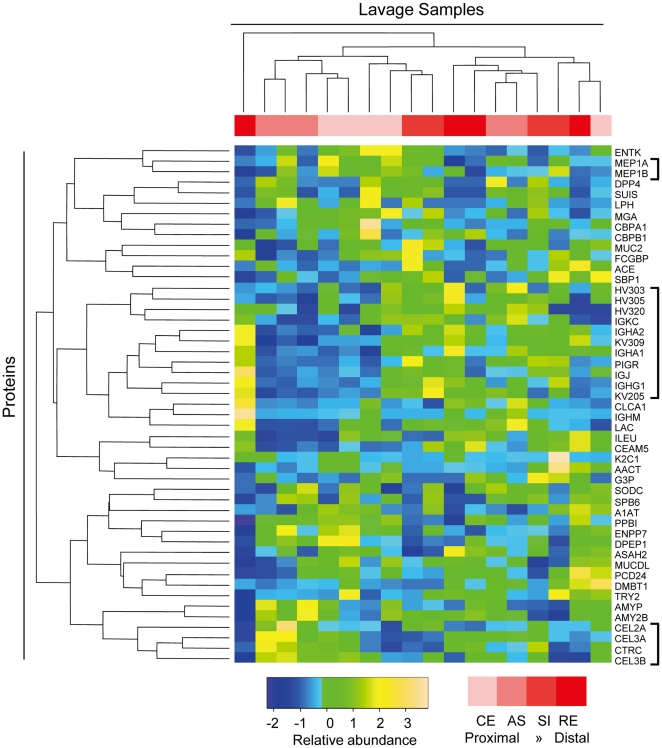
Heatmap view of proteins identified by shotgun proteomics.Horizontal tree indicates 18 independent lavage samples. Vertical tree indicates the 49 proteins analyzed, and the protein identities are listed on the right. Three of the proteins clusters showed biogeographic features are bracketed.